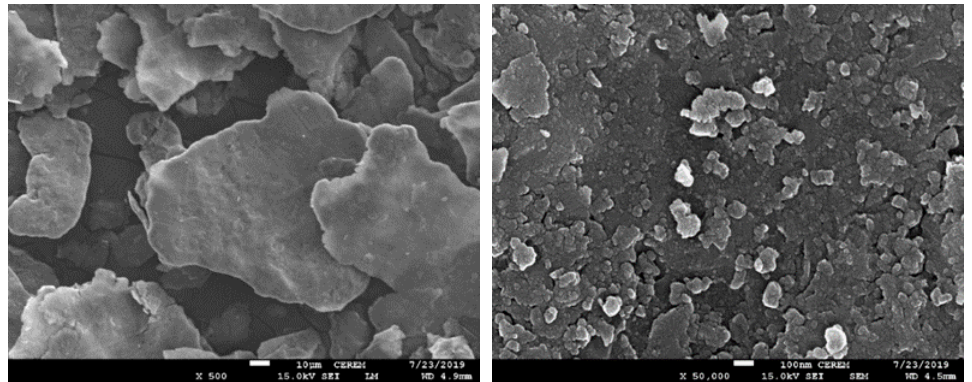
Figure 5. FESEM images for LHSBM-Al powder.